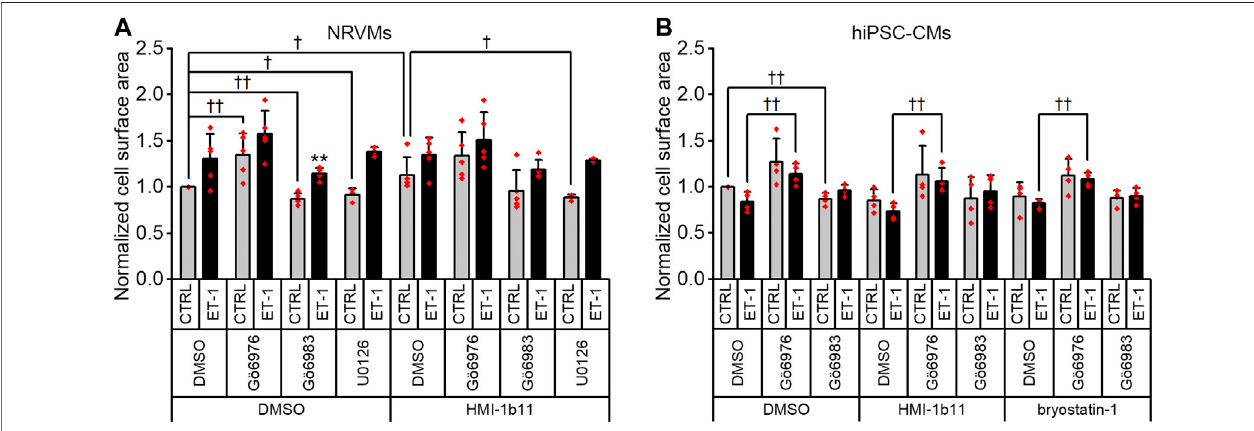
FIGURE 9 | Effects of endothelin-1 (ET-1) and pharmacological PKC inhibition on cardiomyocyte cell surface area. Average cell surface area in NRVMs (A) and in hiPSC-CMs (B) was measured after a 48-h exposure to PKC activators (10 µM HMI-1b11 and 10 nM bryostatin-1), the cPKC inhibitor Gö6976 (1 µM), the pan-PKC inhibitor Gö6983 (1 µM) and MEK1/2 inhibitor (10 µM U0126) with or without 100 nM ET-1. Results are normalized to DMSO control and expressed as mean + SD of independent experiments with CMs from individual cell isolations or differentiations (n (cid:2) 4 for hiPSC-CMs (D32-D49), n (cid:2) 5 for NRVMs, except for U0126 n (cid:2) 3). ** p < 0.01forET-1vs.respectiveCTRL; †† p < 0.01, † p < 0.05asindicated(UnivariateANOVAfollowedbystudent ’ st-testforindependentsamplesforhiPSC-CMsand Kruskall-Wallis followed by Mann-Whitney U for